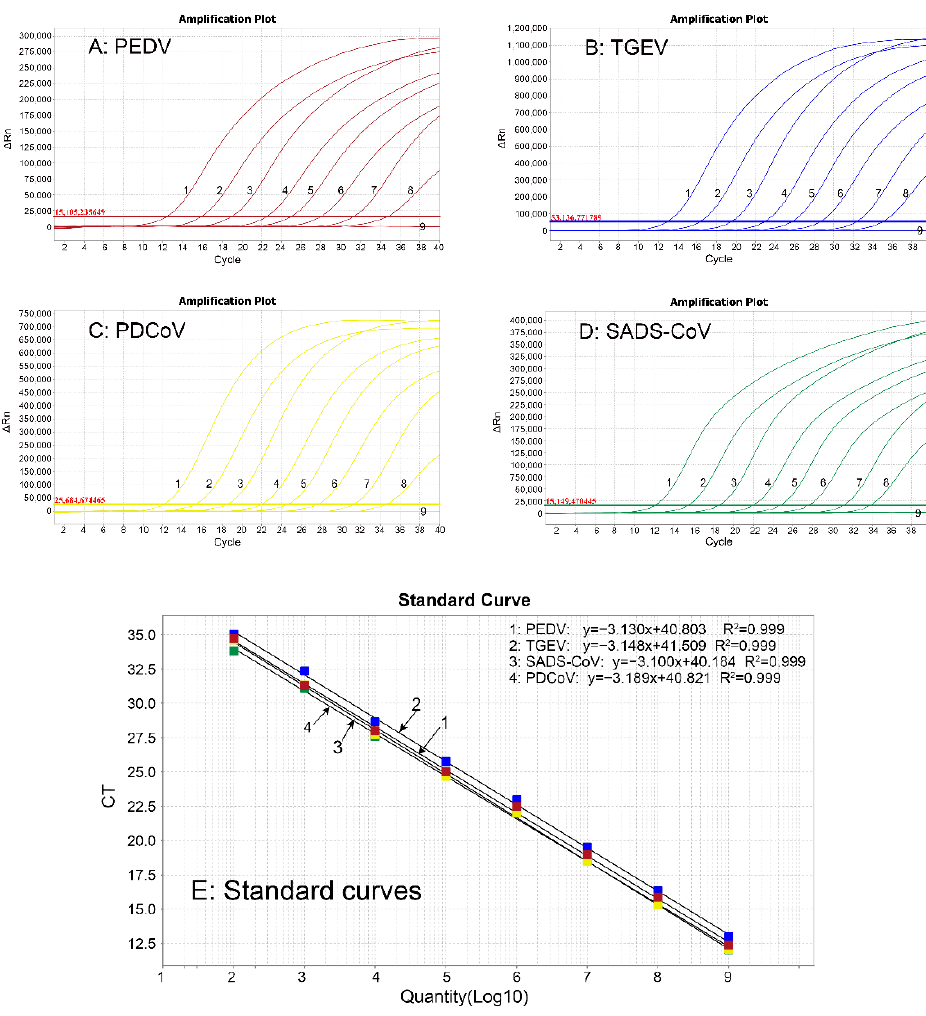
Figure 1. Generation of the standard curves. The amplification curves were generated from the standard plasmid p-PEDV ( A ), p-TGEV ( B ), p-PDCoV ( C ), and p-SADS-CoV ( D ) with different concentrations from 1.21 × 10 9 to 1.21 × 10 2 copies/ µ L (final reaction concentration: 1.21 × 10 8 to 1.21 × 10 1 copies/ µ L), respectively. The standard curves ( E ) showed excellent linear relationship (R 2 ≥ 0.999) between logarithm of templates and their Ct values. Table 2. The components of the optimal reaction